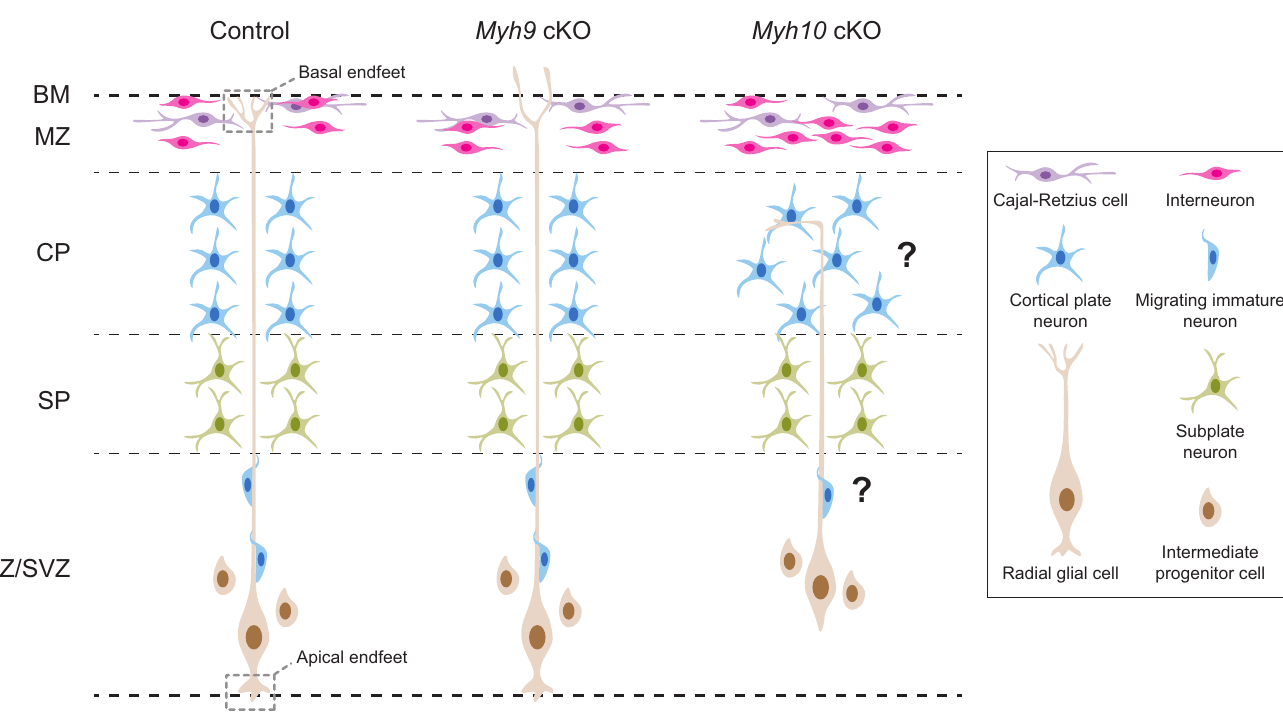
Fig 1. Non-muscle myosins MYH9 and MYH10 control RGC basal endfoot integrity to regulate interneuron organization. In Myh9 cKO cortex, RGCs are less complex basally and have fewer basal endfeet; the basal endfeet protrude abnormally through the basement membrane; interneurons detach from the basement membrane. In Myh10 cKO cortex, RGCs gradually lose apical and basal endfoot attachment; the number of interneurons in the marginal zone increases by ~40%. It would be interesting to determine if migration and organization of cortical plate neurons are also affected by endfoot detachment. BM, basement membrane; cKO, conditional knockout; CP, cortical plate; MZ, marginal zone; RGC, radial glial cell; SP, subplate; VZ/SVZ, ventricular zone/subventricular zone.